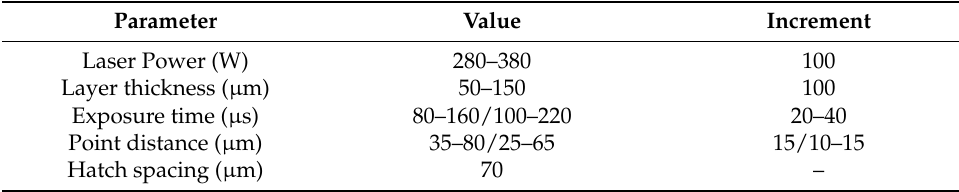
Table 3. The process parameters of the different specimens.